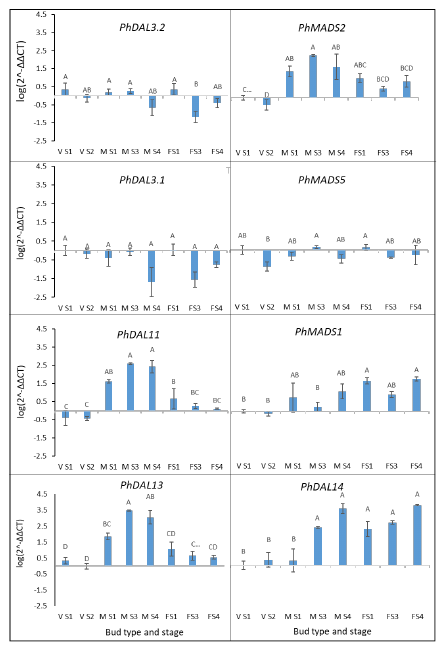
Figure 7. Relative expression levels of eight MADS-box genes in vegetative buds, male, and female cones during several developmental stages. Uppercase letters indicate significant differences ( p < 0.05). Bars represent standard errors. VS1, Vegetative Stage 1; VS2, Vegetative Stage 2; MS1, Male Stage 1; MS3, Male Stage 3; FS1, Female Stage 1; FS3, Female Stage 3; FS4, Female Stage 4.